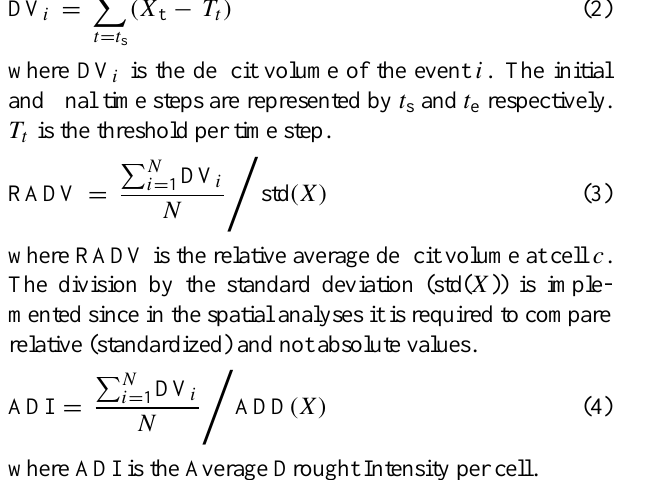
Fig. 3. Drought characteristics calculated with defined variable threshold: (a) Hydrological variable and vari- able threshold, (b) daily intensity, (c) event deficit volume. Start and end of the events are named as 1 and 2